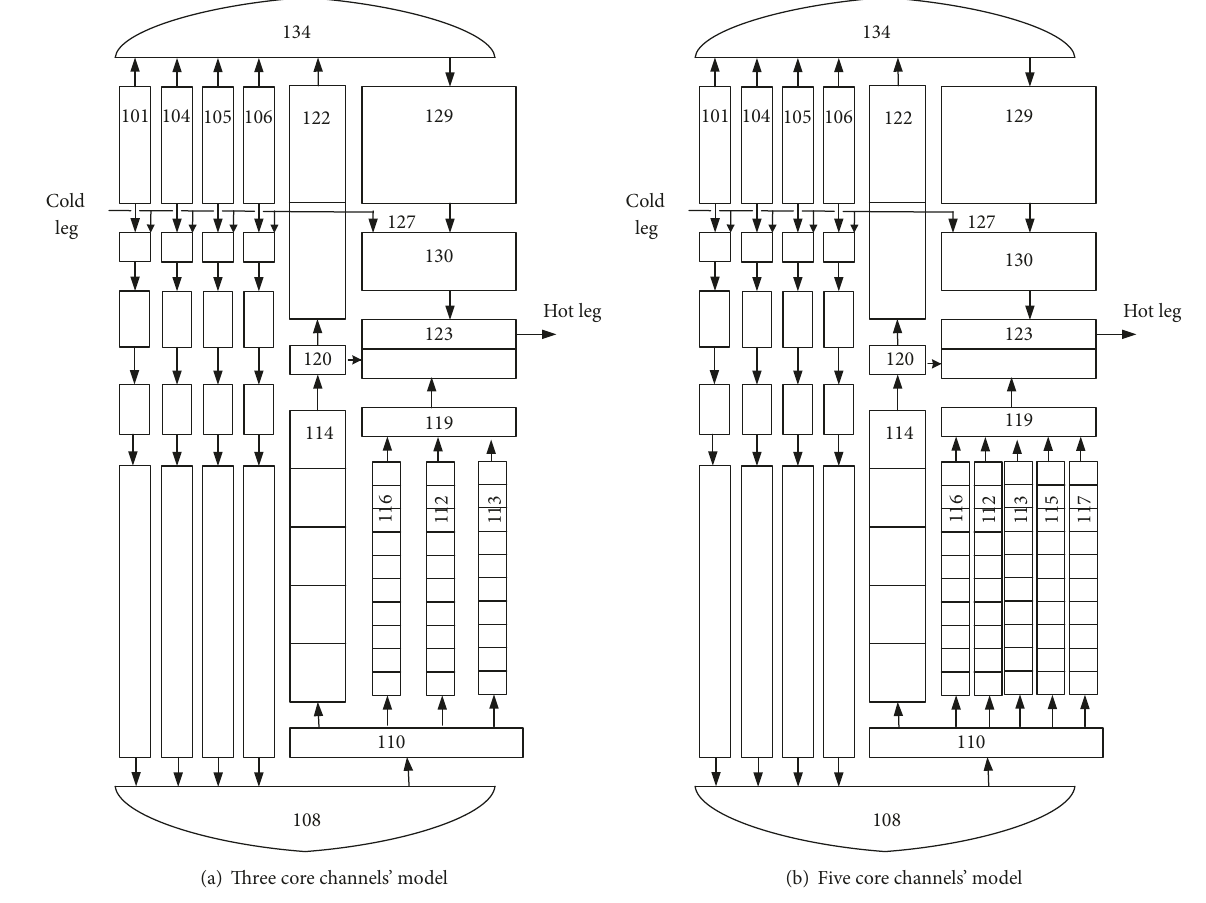
Figure 3: Reactor core division models of AP1000 Nuclear Power Plant. Table 1: The influence of core channel node number on the coolant temperature